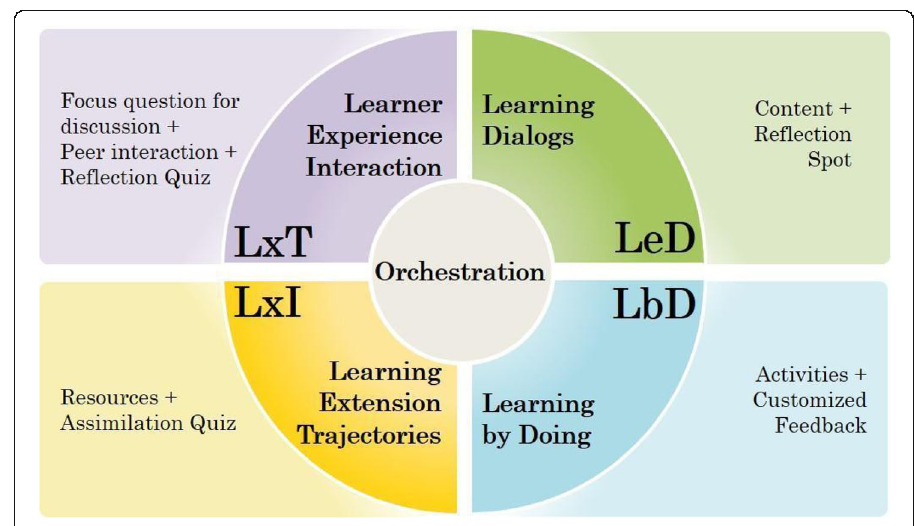
Fig. 1 Overview of Learner-Centric MOOC (LCM) Model (Murthy et al.,